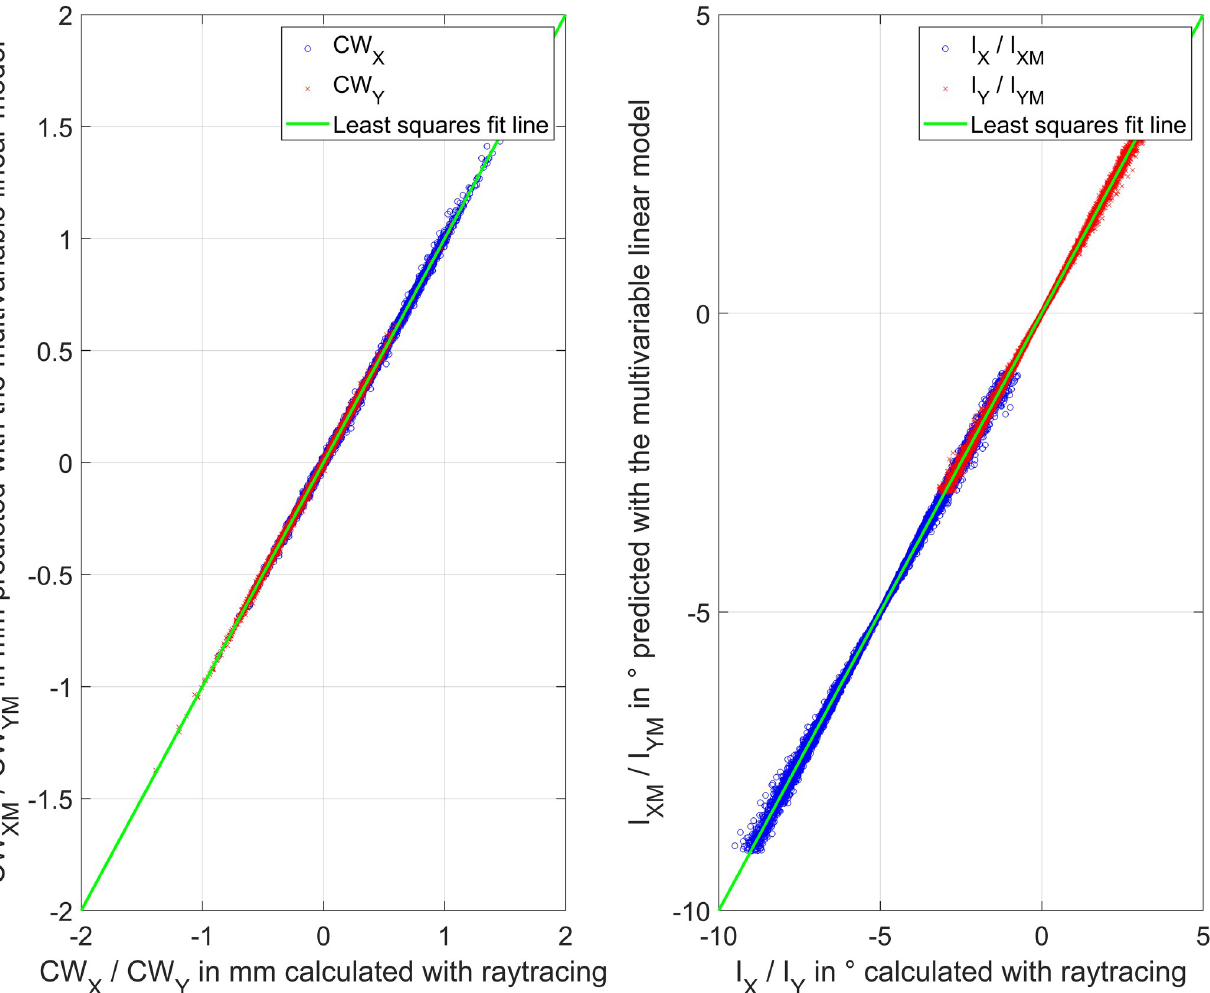
Fig 3. Performance of the linear models: In the left graph the predicted Chang-Waring chord from the linear multivariable model (X and Y components CW XM and CW YM ) is plotted versus the respective components derived from raytracing calculations (X and Y components CW X and CW Y ). In the right graph the reverse model is shown, where the predicted incident ray angle from the linear multivariable model (X and Y components I XM and I YM ) is plotted versus the respective components derived from raytracing calculations (X and Y components I X and I Y ). The model is based on a dataset with N = 8959 eye